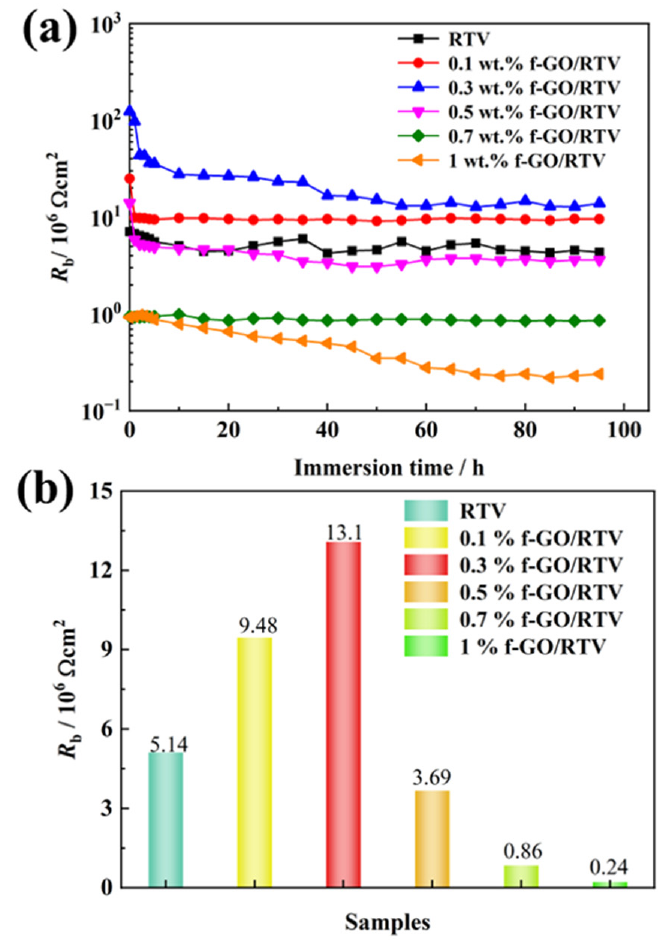
Figure 9. The variation in coating resistance Rb of RTV nanocomposite coatings filled with different contents of f-GO nanosheets after NO2 oxidation: ( a ) with different immersion time, ( b ) the final Rb after immersing for 96 h.